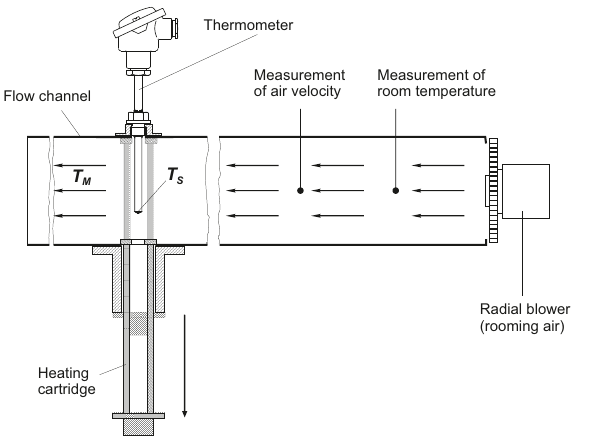
Figure 5. Flow channel according to